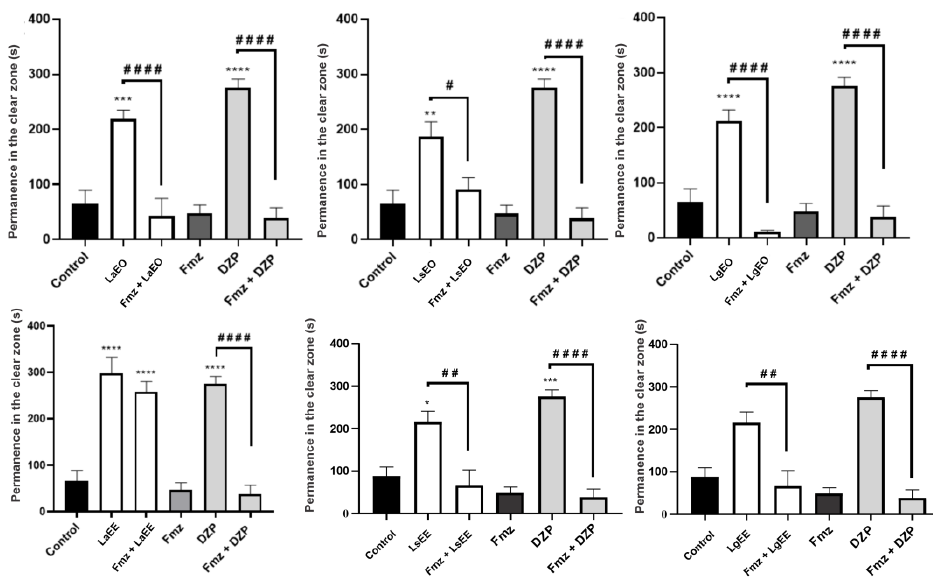
Figure 6. Involvement of GABAergic neurotransmission in the anxiolytic effect of essential oils and ethanolic extracts of L. alba , L. sidoides , and L. gracilis in the light/dark test (0 – 5 min). The values represent the mean ± standard error of the mean of six animals/group; ANOVA followed by Tukey’s test (* p < 0.05, ** p < 0.01, *** p < 0.001, **** p < 0.0001, vs. control; # p < 0.05, ## p < 0.01, #### p < 0.0001